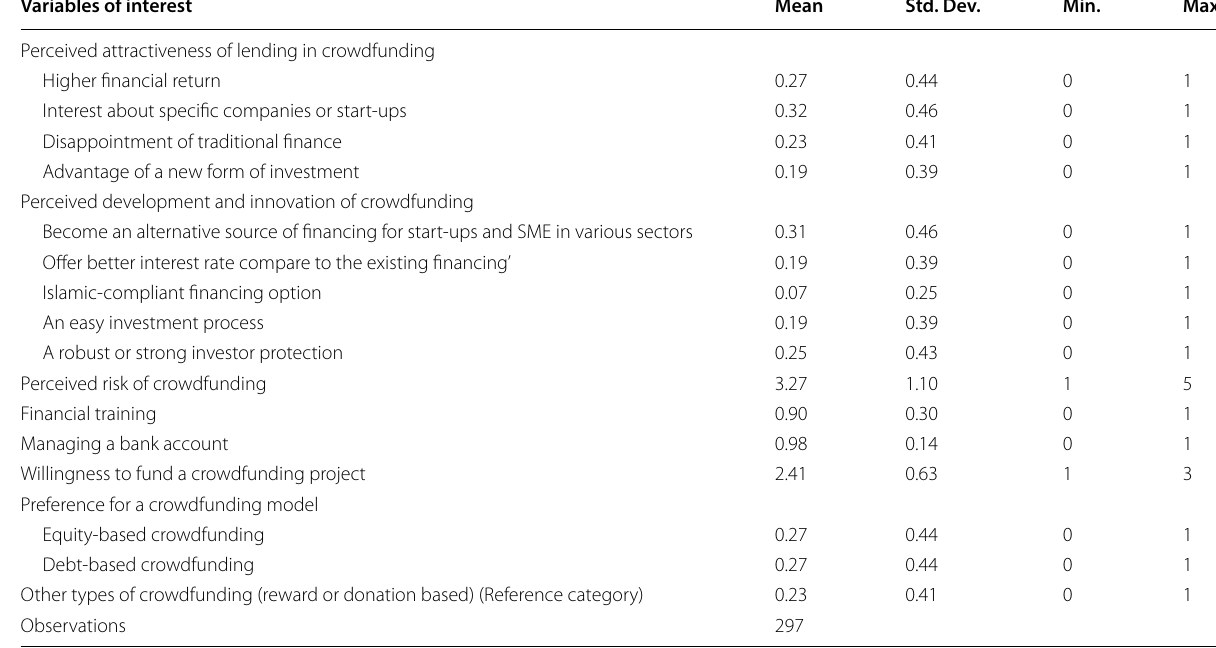
Table 3 Summary statistics of variables Variables of